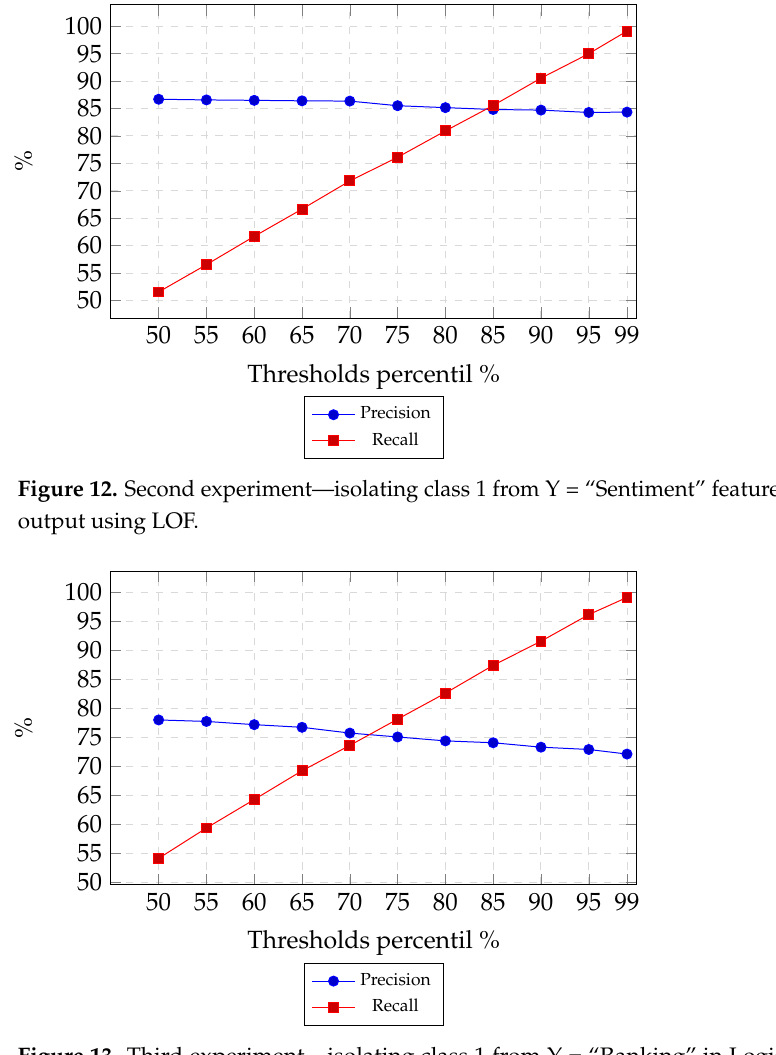
Figure 13. Third experiment—isolating class 1 from Y = “Ranking” in Logistic Regression output using